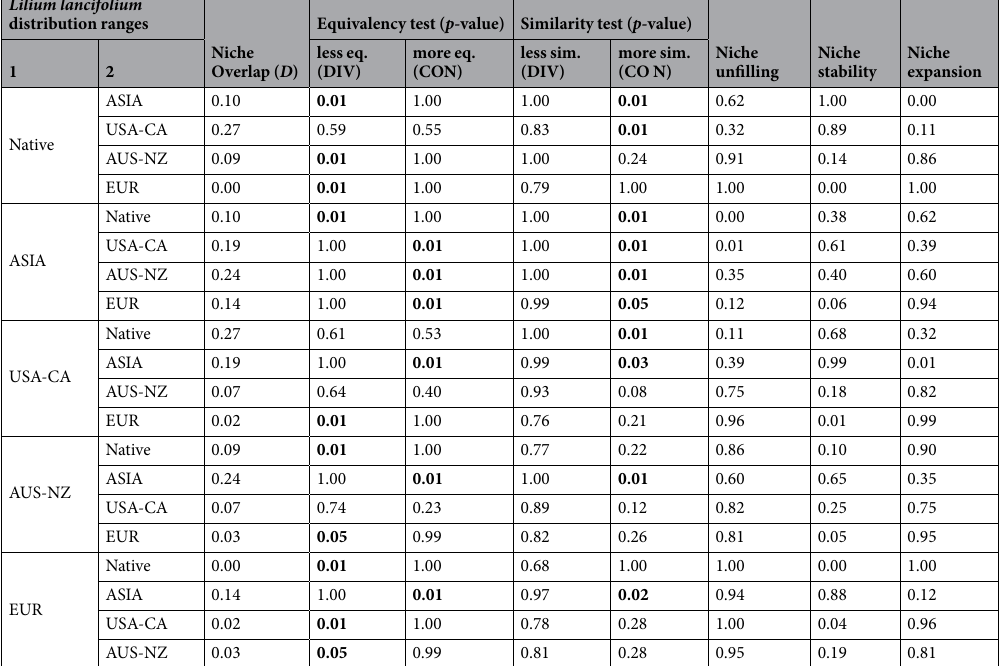
Table 2. Metrics of niche dynamics comparing pairs of Lilium lancifolium ranges (1 → 2), following the methodological framework developed by Broennimann et al . 36 . Interpretation of niche parameters: overlap ( D ; 0 = no overlap, 1 = complete overlap), less equivalent or less similar (significant values when p < 0.05, indicating that niches are less equivalent/similar than expected by chance), more equivalent or more similar (significant values when p < 0.05, indicating that niches are more equivalent/similar than expected by chance), unfilling (0 = totally filled, 1 = totally unfilled), stability (0 = not stabilized, 1 = totally stabilized), expansion (0 = in equilibrium, 1 = fully in expansion). Note that the last three metrics were calculated by the intersection between the thin lines of compared ranges (100% percentile of occurrence density; Fig. 5B). Abbreviations used: eq. = equivalent; sim. = similar; DIV = divergent; CON =